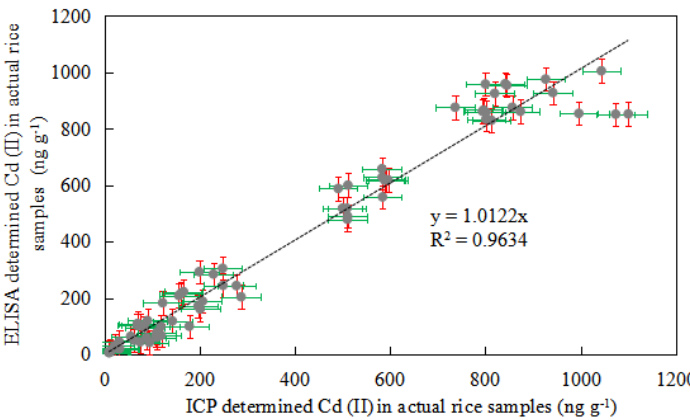
Figure 7. Correlation between Ic-ELISA and ICP-AES analysis of Cd (II) in actual food packaging samples (12 samples with detection repeated three times).